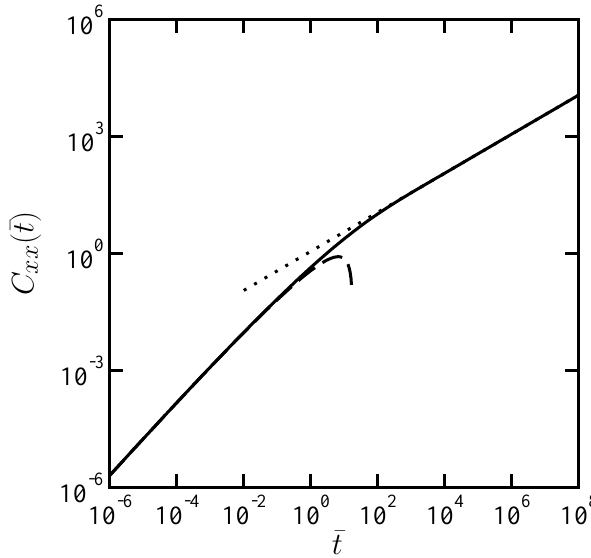
Figure 2. Scaled longitudinal cross-correlation function C ¯ t when (cid:11) = 1 = 2 . These dimensionless quantities are defined in the text. The dotted and dashed lines correspond to the asymptotic expressions given by Equations (11) and (13),